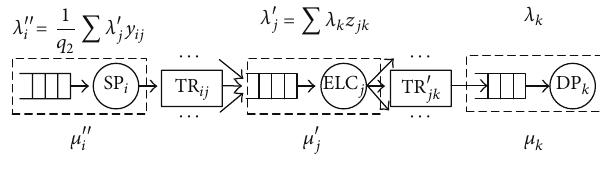
Figure 2: Equivalent queue of studied ESC